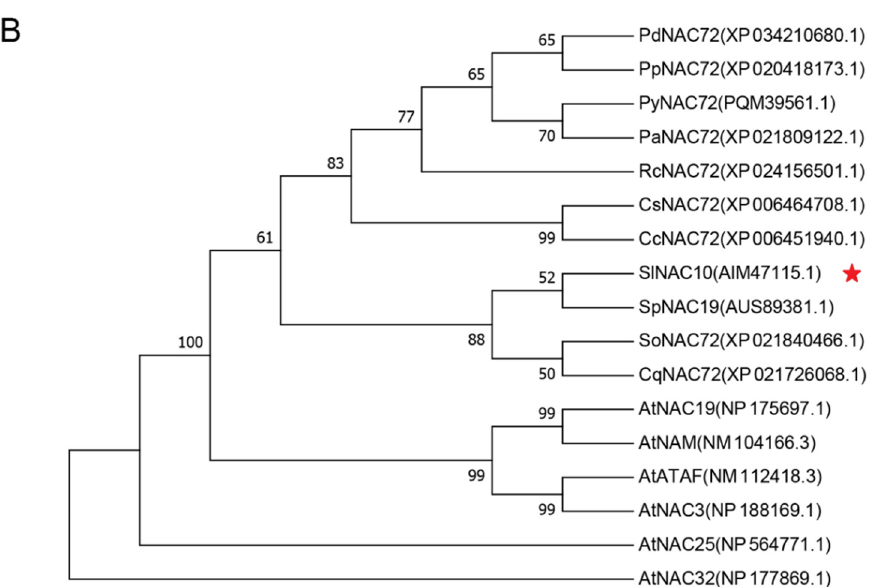
Figure 1. Multiple alignments and phylogenetic tree of Sl NAC10 with other NAC proteins. ( A ) Comparison of Sl NAC10 protein with NAC proteins from other plant species. Residues that are conserved in all proteins are highlighted. The five subdomains of the NAC domain are denoted by lines designated with the letters A–E. ( B ) Evolutionary tree analysis of Sl NAC10 (indicated by a red star) and other NAC proteins. The accession numbers are as follows: SlNAC10 ( Suaeda liaotungensis , AIM47115.1), PdNAC72 ( Prunus dulcis , XP_034210680.1), PpNAC72 ( Prunus persica ,